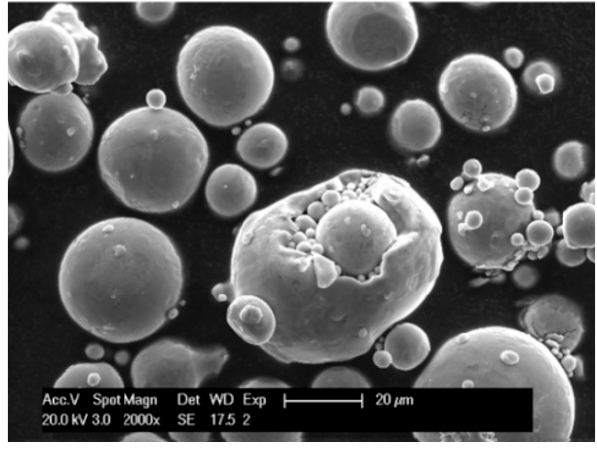
Figure 2. Spherical morphology of Ti64 powder with satellite particles and particles inside particles. Table 1. Chemical composition of Ti64 powder (wt.%).